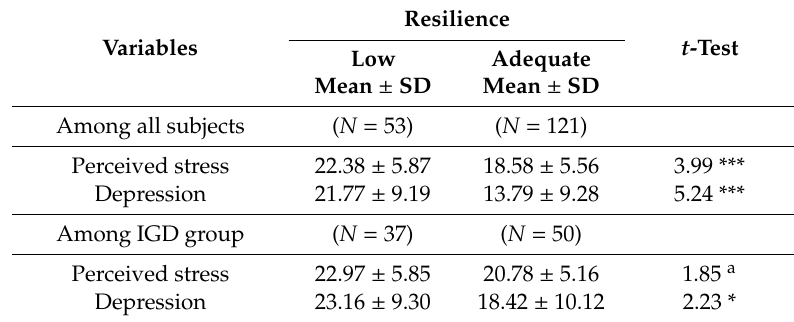
Table 2. The di ff erence in perceived stress and depression between individuals with low resilience and those with adequate